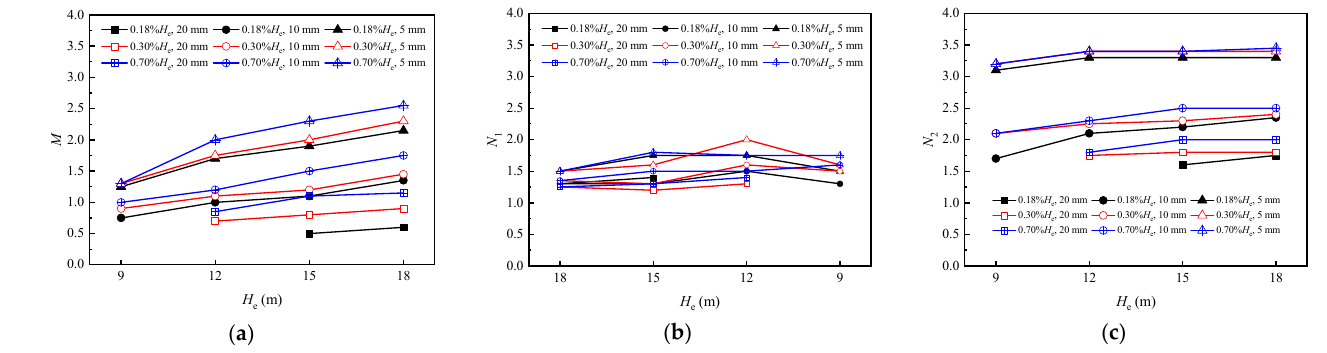
Figure 10. E ff ect of H e on M , N 1 and N 2 : ( a ) E ff ect of H e on M ; ( b ) E ff ect of H e on N 1 ; ( c ) E ff ect of H e Figure 10. Effect of H e on M , N 1 and N 2 : ( a ) Effect of H e on M ; ( b ) Effect of H e on N 1 ; ( c ) Effect of H e on N 2 . on N 2